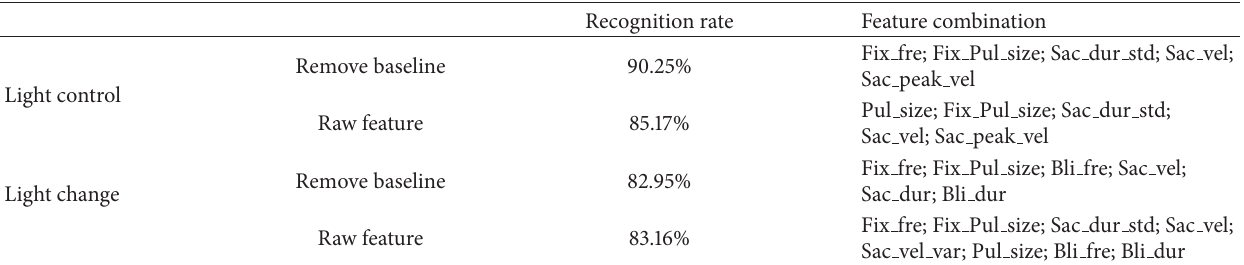
Table 5: The recognition rates and features